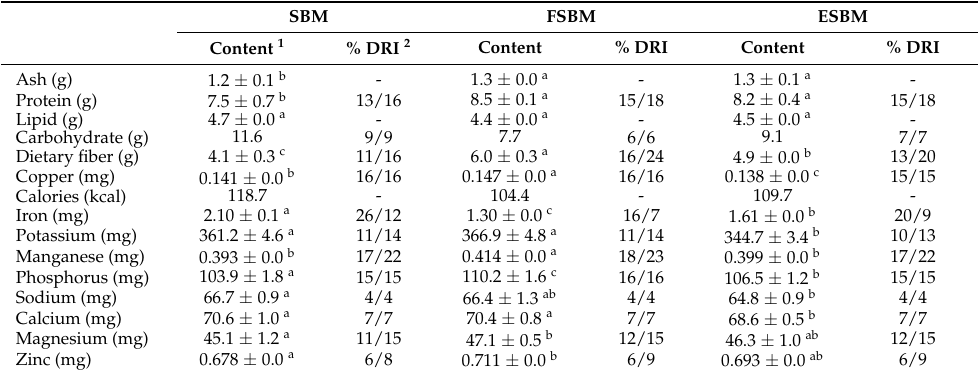
1 Mean value of three replicates, expressed in fresh weight basis. Means in the same row with different superscript letters are significantly different (ANOVA followed by Tukey’s post hoc test; p < 0.05) Coefficient of variation was lower than 10%. 2 The percentage of the dietary recommended intake for men/women, respectively, achieved by consuming one portion of biscuits (30 g, equal to 5 or 6 units) (see DRI—Dietary Reference Intakes: https://ods.od.nih.gov/HealthInformation/Dietary_Reference_Intakes.aspx, accessed on 20 October 2022). The total contents of isoflavones in SBM, FSBM and ESBM biscuits were 99 mg/100